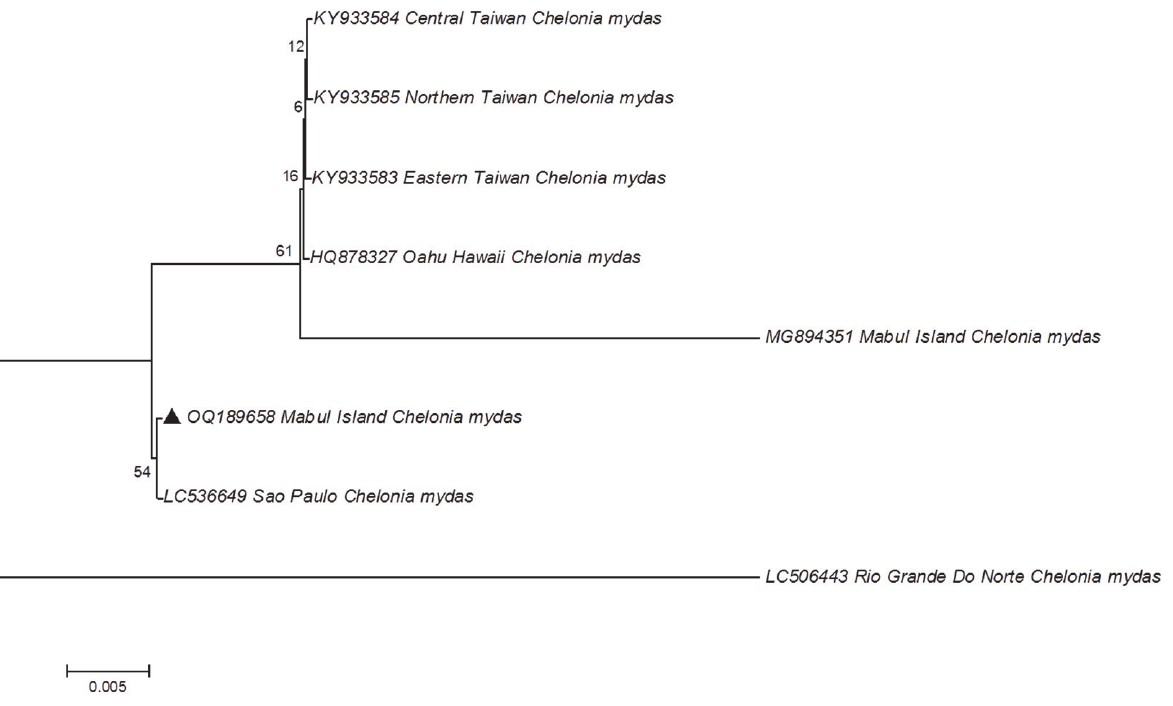
Figure 3. Phylogenetic tree of ChHV5 partial major capsid protein variants inferred using the maximum likelihood method (Tamura’s three-parameter model). The sample from this study is indicated with a black triangle.